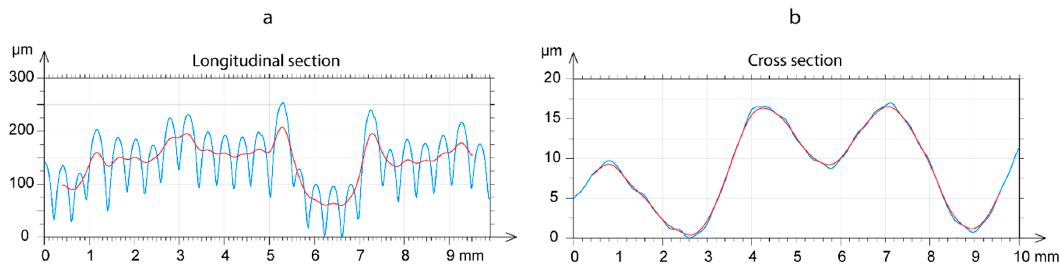
Figure 10. Detail of surface 3D topography: ( a ) On-edge, and ( b ) flat.